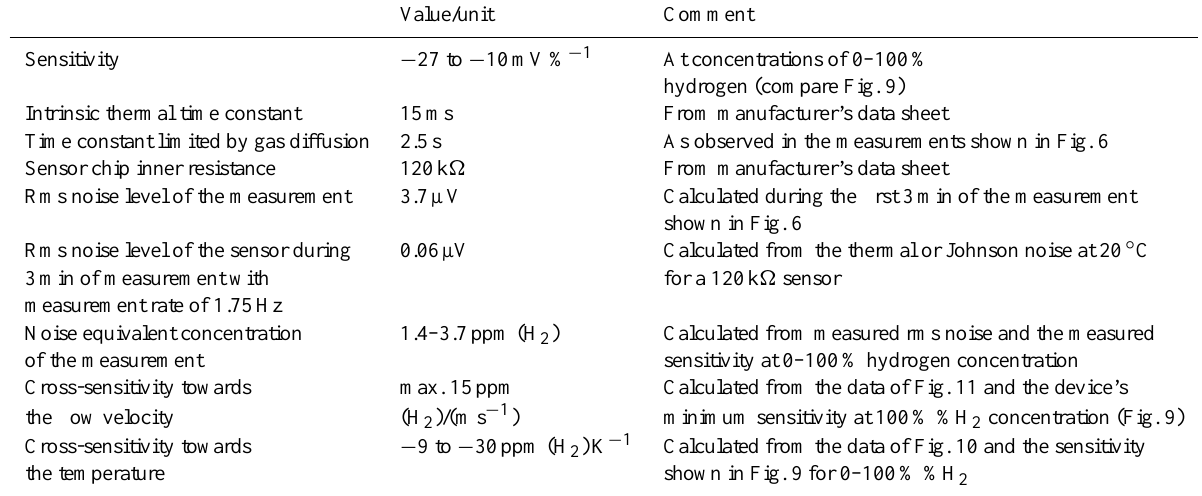
Table 2. Compilation of basic sensor and measurement specifications.